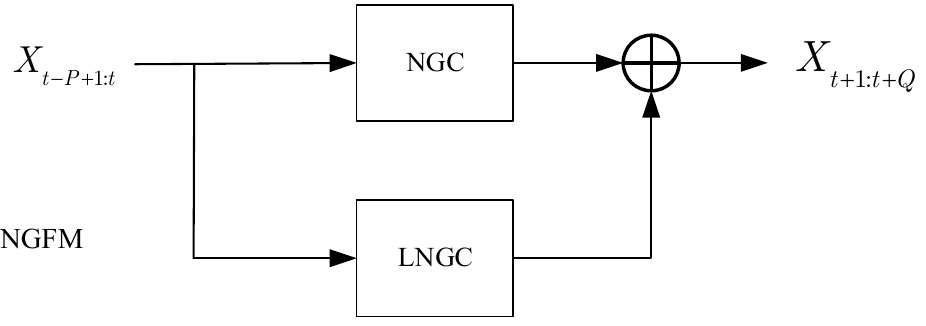
Figure 3. Overall framework of the NGFM model.